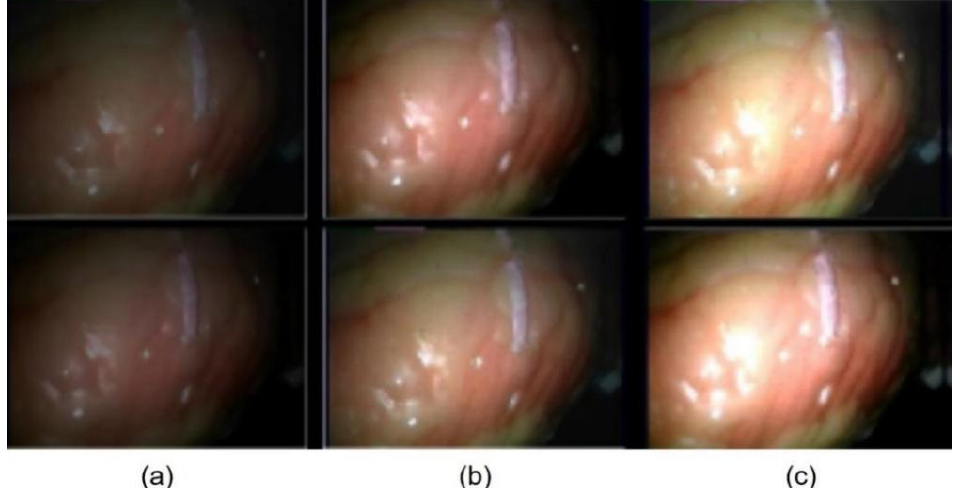
Figure 3. Left and right images of three different brightness cardiac models. ( a ) 1/2 brightness left and right images; ( b ) original brightness left and right images; ( c ) 3/2 brightness left and right images The mismatching rates of the disparity map corresponding to the traditional census and the improved census are counted, respectively, as shown in Table 1.